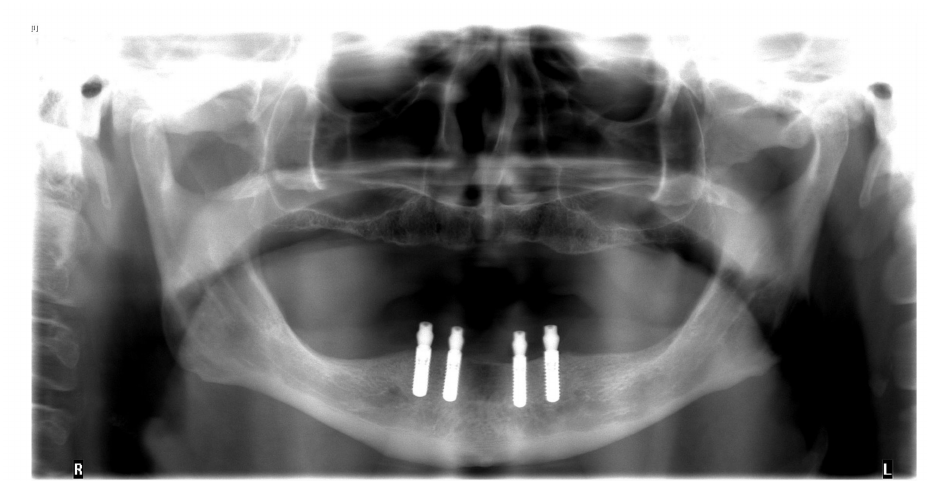
Figure 1. Orthopantomogram after insertion of four implants in the lower jaw.